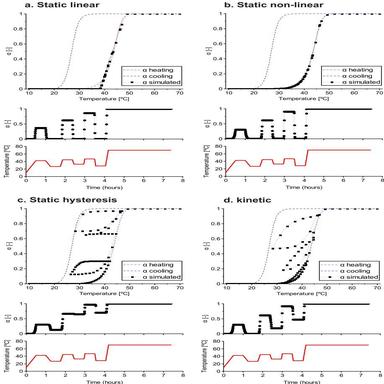
Simulations of phase transition models for a temperature profile where heating and cooling ramps are reversed during incomplete phase change and heating/ cooling rate increases with time (1, 2.5 and 5 ◦C⋅min− 1 ). Simulation time step of 0.01 hour. First plot: predicted phase fractions (α) as a function of temperature. Second: predicted phase fractions (α) as a function of time. Third: temperature profile induced as a function of time.